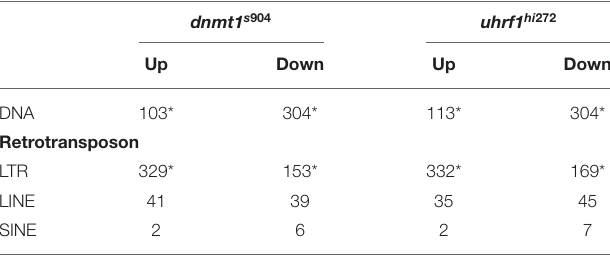
TABLE 1 | Transposable elements are differentially expressed in dnmt1 − / − and uhrf1 − / − mutant livers at 5 dpf. dnmt1 s 904 uhrf1 hi 272 Up Down Up Down DNA 103*